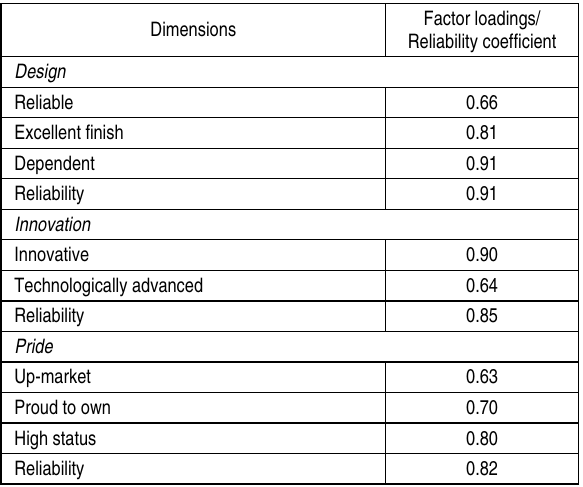
Table 1. Factor loadings of country image dimensions